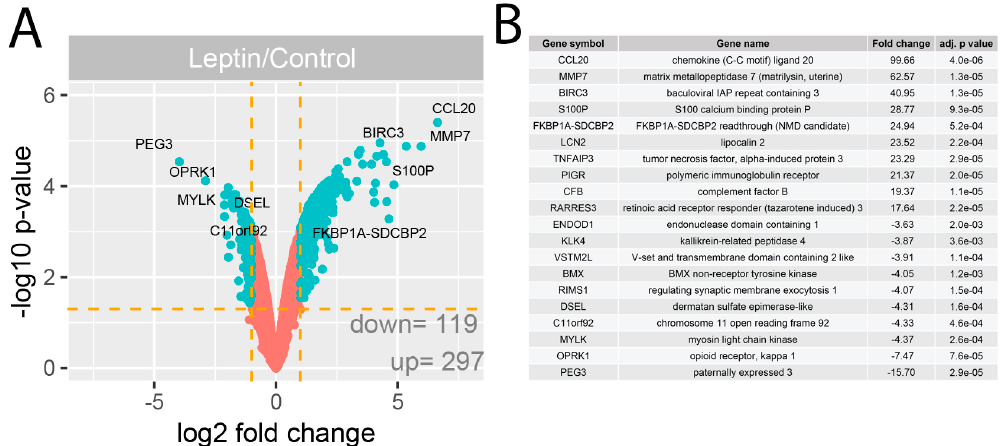
Figure 2. ( A ) Volcano plots of total gene expression profiles of the LNCaP prostate cell line after 24 h incubation with LEP (1 × 10 − 6 M). Each dot represents the mean expression ( n = 2) of the individual gene obtained from a microarray normalized dataset. The orange dotted lines (cut off values) were established according to the following parameters: fold = | 2| and p -value with FDR correction = 5 %. Genes above the cut-off lines have been considered as differentially expressed genes (DEG) and are shown as turquoise dots. The total numbers of DEG are presented in the bottom right corner of the graph. Ten the most regulated genes are marked by their gene symbols. ( B ) List of 20 genes with the highest (10 genes) and lowest (10 genes) fold changes obtained from the datasets of differentially expressed genes.